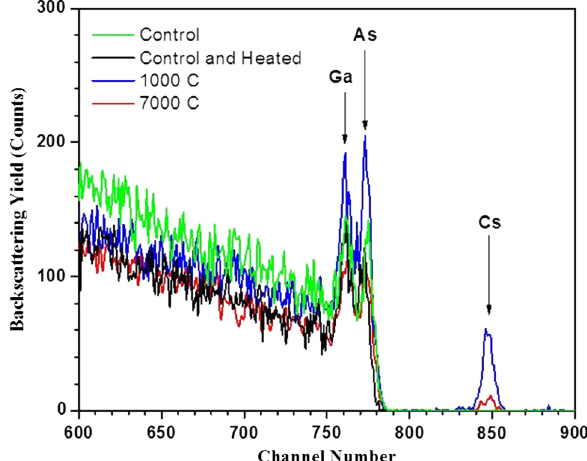
FIG. 4. Channeling Rutherford backscattering spectra of con- trol, heated control, 1000, and 7000 coulomb samples (green, black, blue, and red lines, respectively) taken within the drive laser-illuminated region near the electrostatic center shows the expected surface composition, with peaks due to Ga, As, and